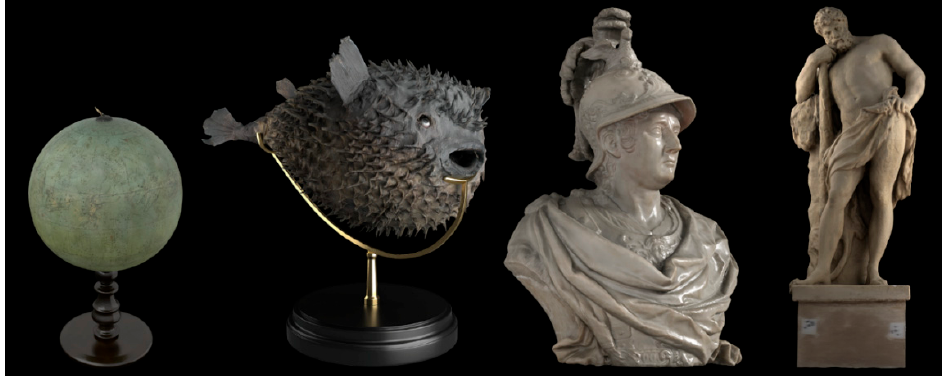
Figure 1. Results from our workflow.